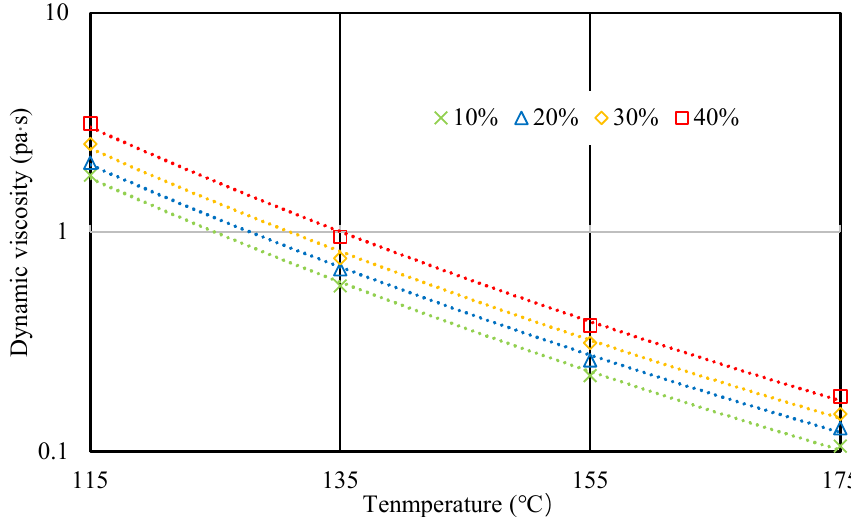
Figure 13. Viscosity of BRA-MA with 40% BRA with logarithmic axis.